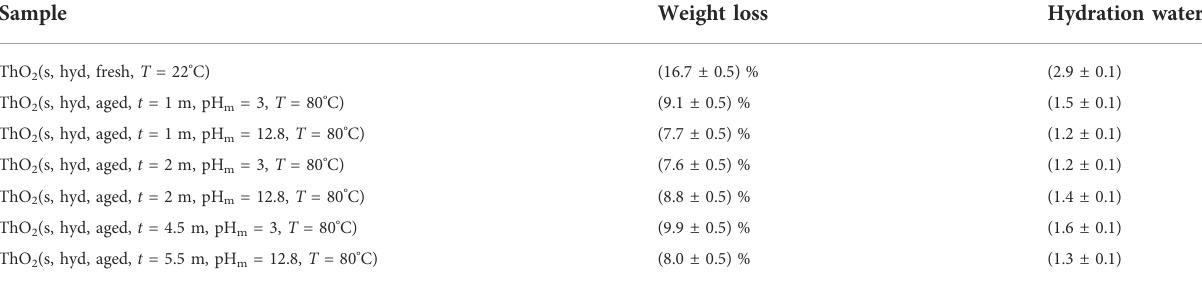
TABLE 2 Weight loss and calculated number of hydration waters as quanti fi ed by TG-DTA for the Th(IV) hydrous phases investigated in this work. Sample Weight loss